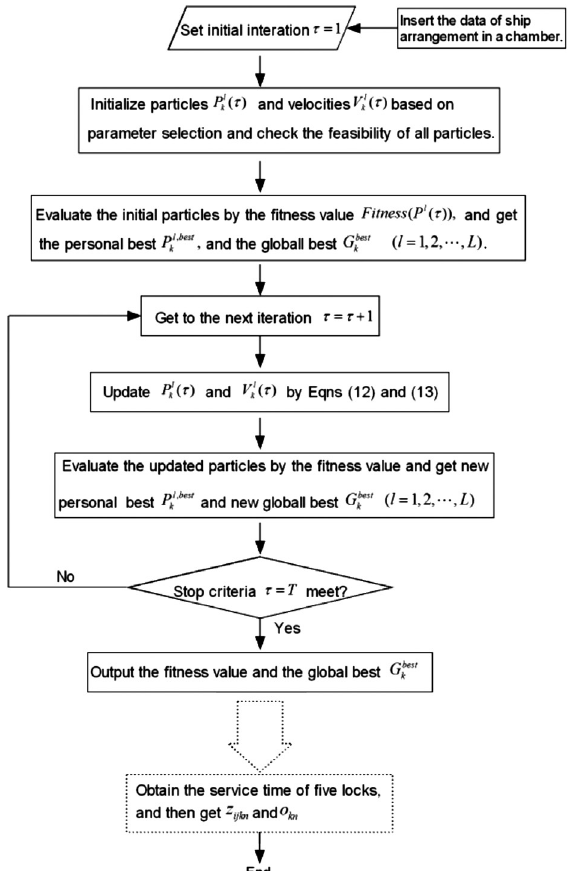
Fig. 9. Procedure of the PSO framework